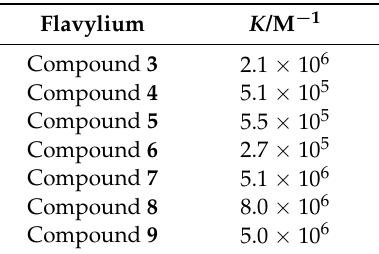
Table 6. Association constants ( K ) for the formation of host–guest complexes between flavylium cations and cucurbit[7]uril at pH 1. The estimated error is below 10%.